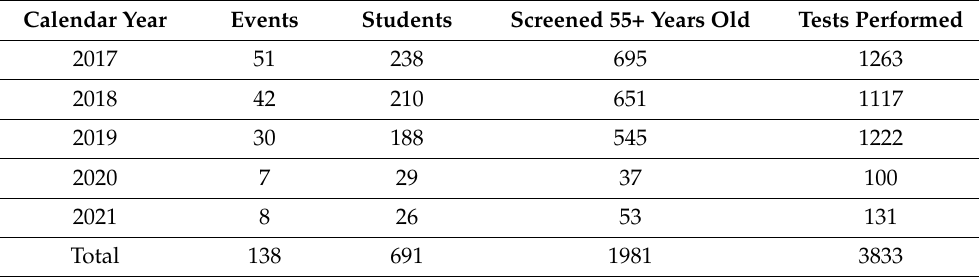
Table 2. Number of events, students, older adults screened, and screening tests performed from 2017–2021.